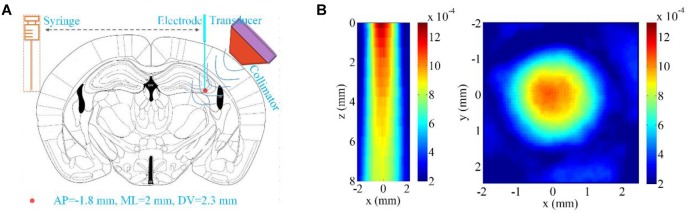
Ultrasound stimulation region and ultrasound field distribution. (A) The region for drug injection and LFP recording (AP = -1.8 mm, ML = 2 mm, DV = 2.3 mm relative to Bregma). (B) The two-dimensional ultrasound distribution in the xz and xy planes.